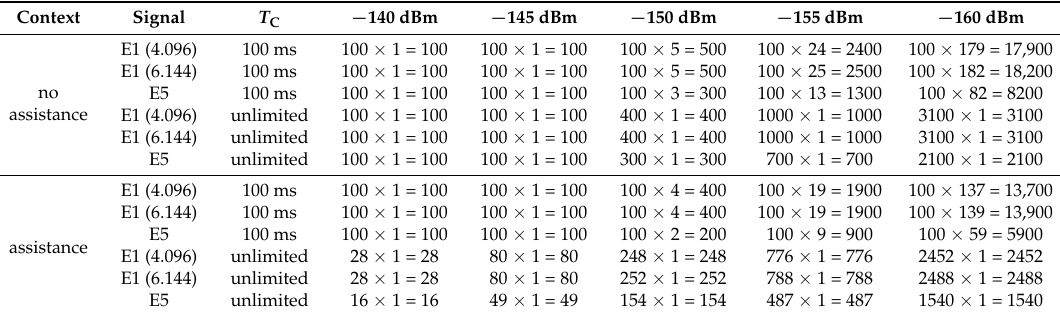
Table 16. Total integration time T IT = T C × N NC as function of the sensitivity and context with Galileo signals, for average losses. Note that the sensitivities given are for the L1 C/A signal; those of E1 are 1.5 dB lower and those of E5 are 0.5 dB higher.